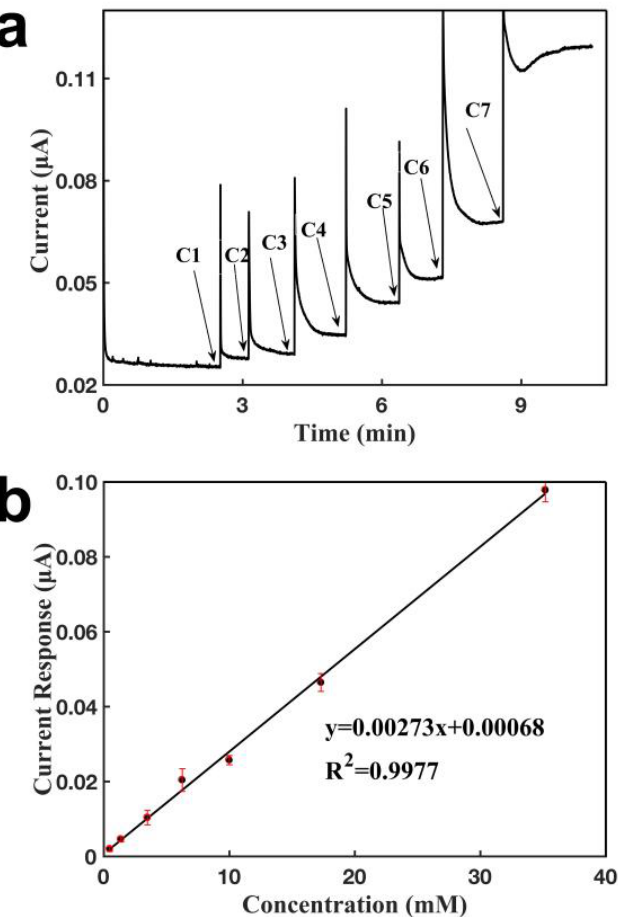
Figure 3. Characterization of the glove sensor based on two CNT electrodes for the detection of H 2 O 2 . Operating potential: 0.6 V of working electrode vs reference electrode (CNT). ( a ) Current-versus-time response curve upon the additions of H 2 O 2 . C1: 0.48 mM, C2: 0.89 mM, C3: 2.11 mM, C4: 2.77 mM, C5: 3.75 mM, C6: 7.30 mM, C7: 17.88 mM. ( b ) Calibration curve for the detection of H 2 O 2 . Each error bar was from three measurements.